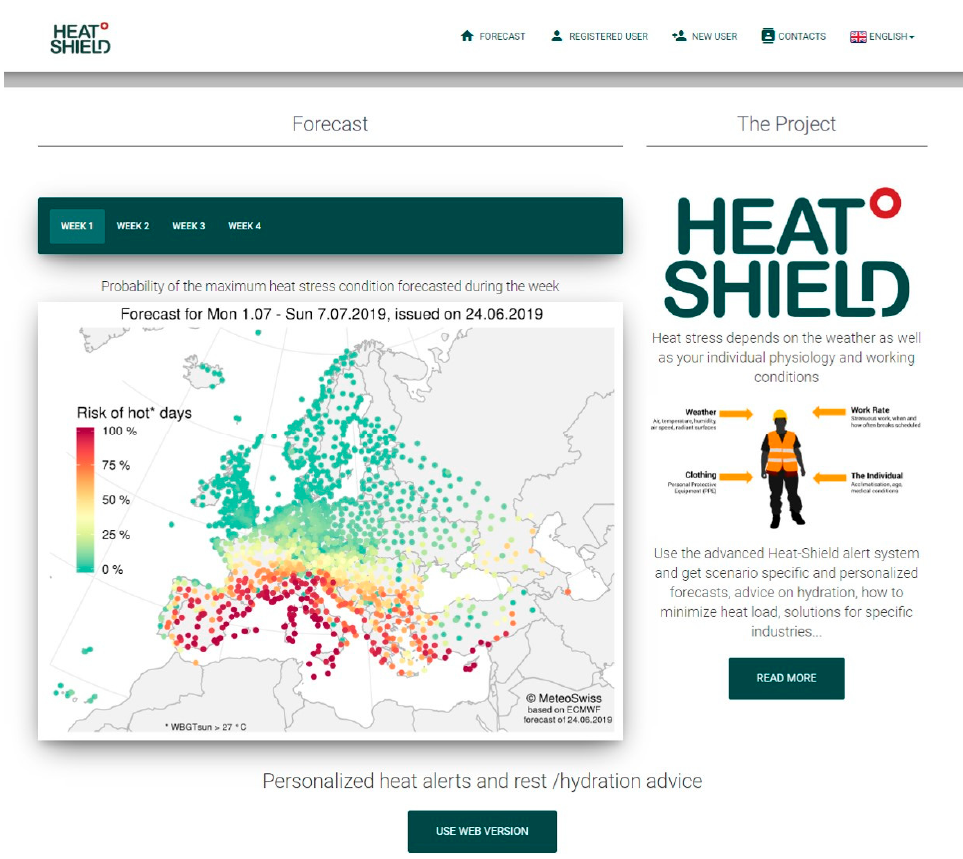
Figure 2. Home page of the HEAT-SHIELD occupational warning system [24].